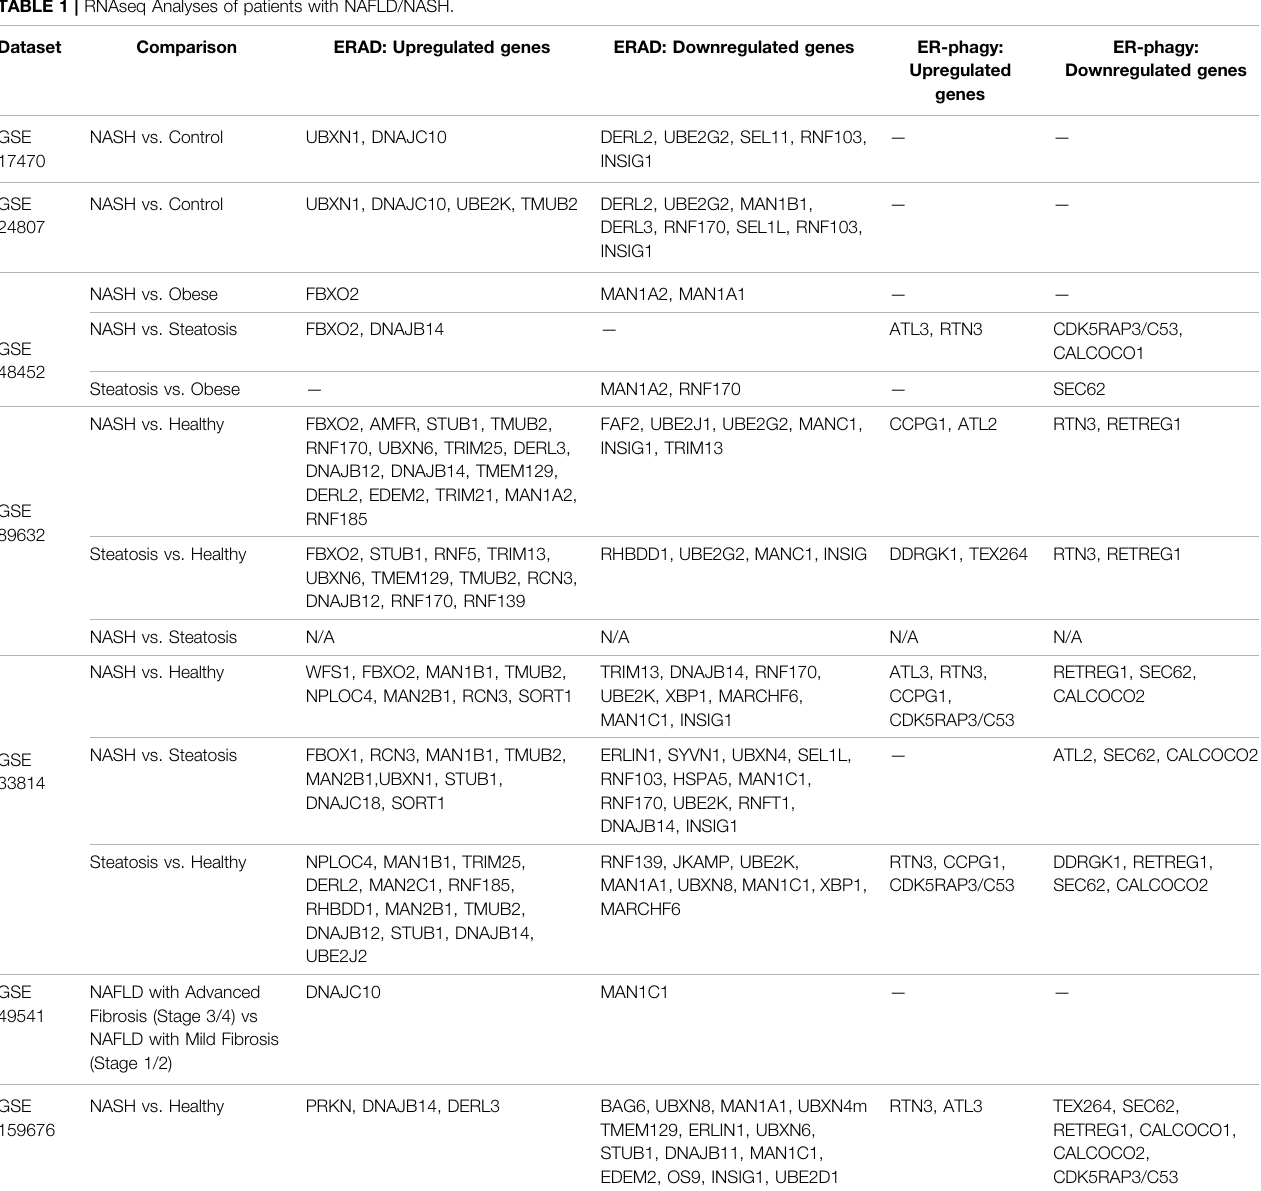
TABLE 1 | RNAseq Analyses of patients with NAFLD/NASH.